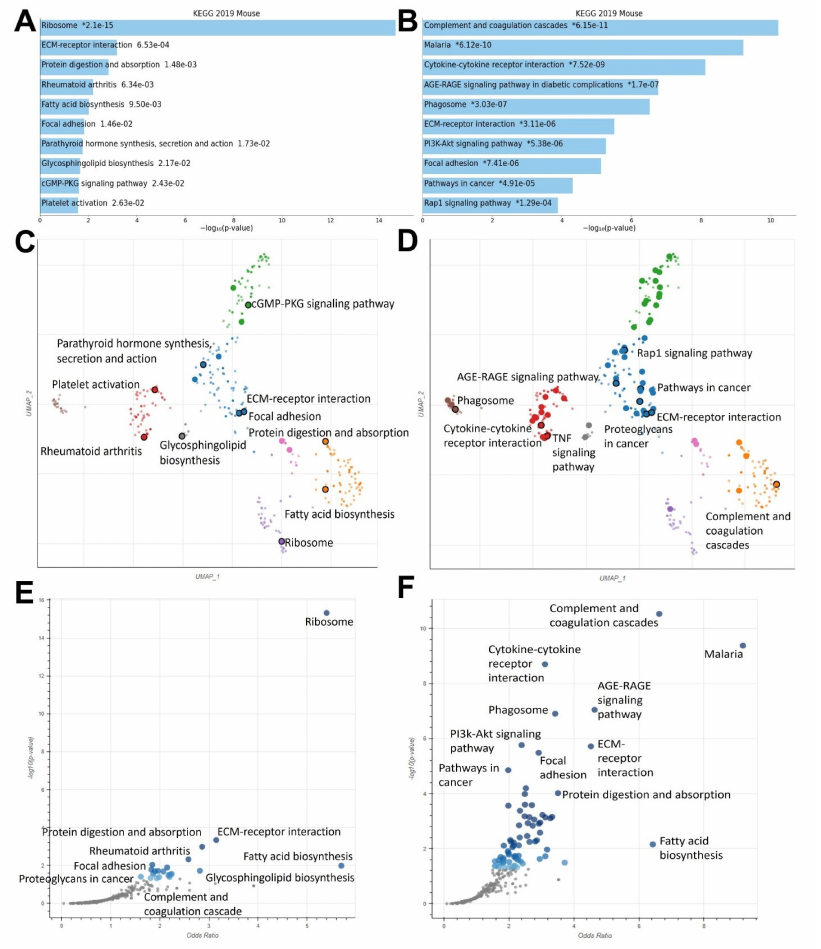
Figure 4. MSU-42011 and bexarotene induce unique gene expression profiles with some unifying characteristics in treated mammary tumors of a HER2+ murine model. ( A , B ) Bar graph of differen- tially regulated pathways in MSU 42011-treated vs. control tumors ( A ) and bexarotene-treated vs. control tumors ( B ) using the KEGG 2019 Mouse database in Enrichr. ( C – F ) Scatterplot ( C , D ) and volcano plot ( E , F ) depictions of differentially regulated pathways in MSU-42011-treated vs. control tumors ( C , E ) and bexarotene-treated vs. control tumors ( D , F ). * = p